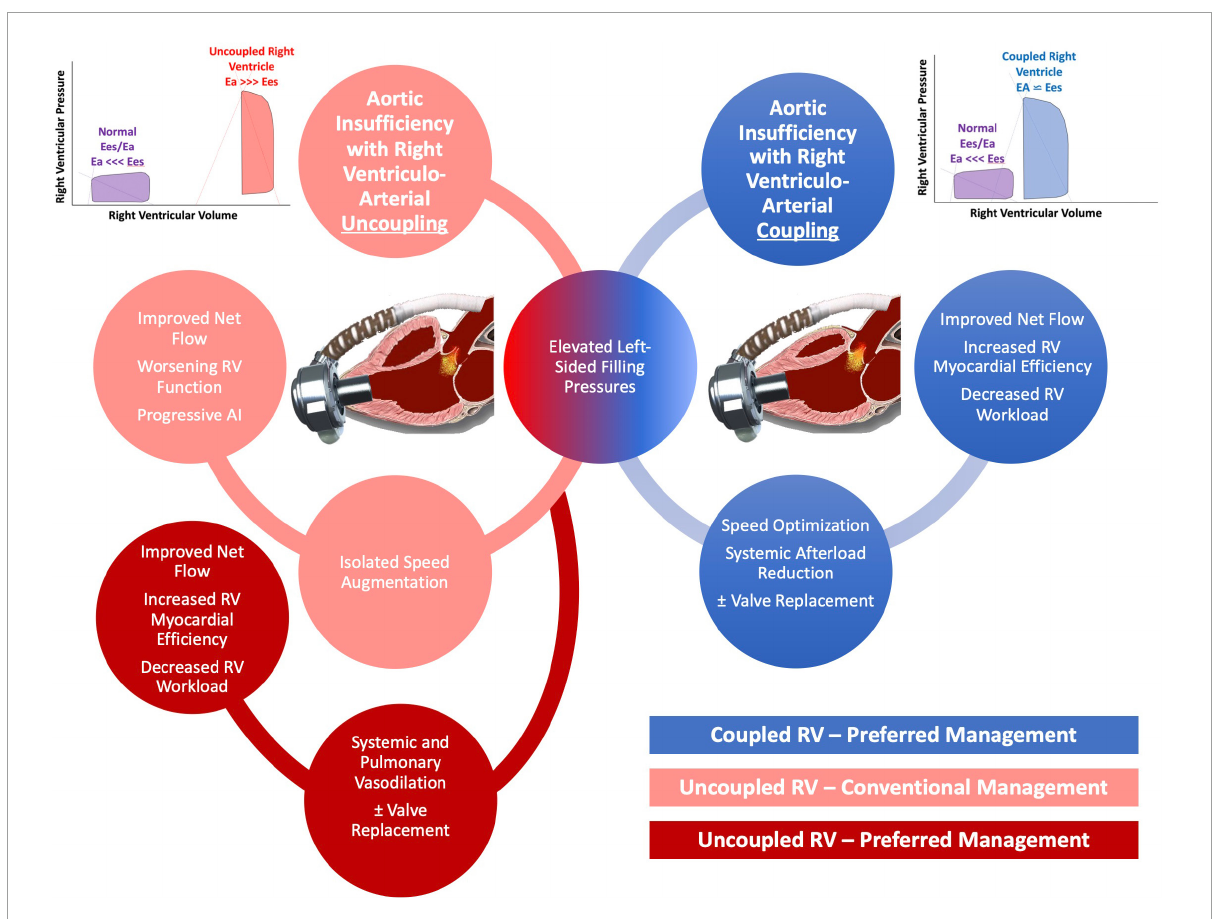
FIGURE5 Schematic of proposed management of aortic insufficiency (AI) based on degree of right ventricular (RV) uncoupling.